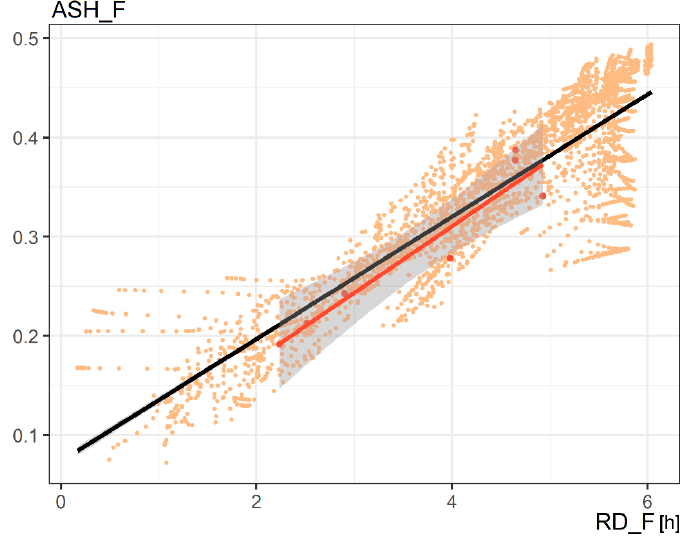
Figure 18. Linear regression function of façade-based L-metrics RD_F and ASH_F based on neigh- bourhood iterations (black line) and case studies (red line), including the 95% CI for the case studies regression line indicated by the grey area.